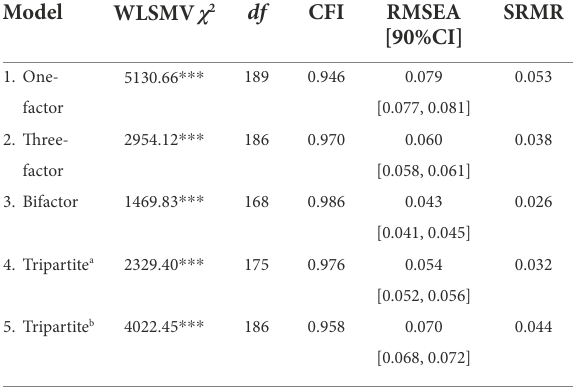
TABLE 3 Fit indices of the evaluated CFA